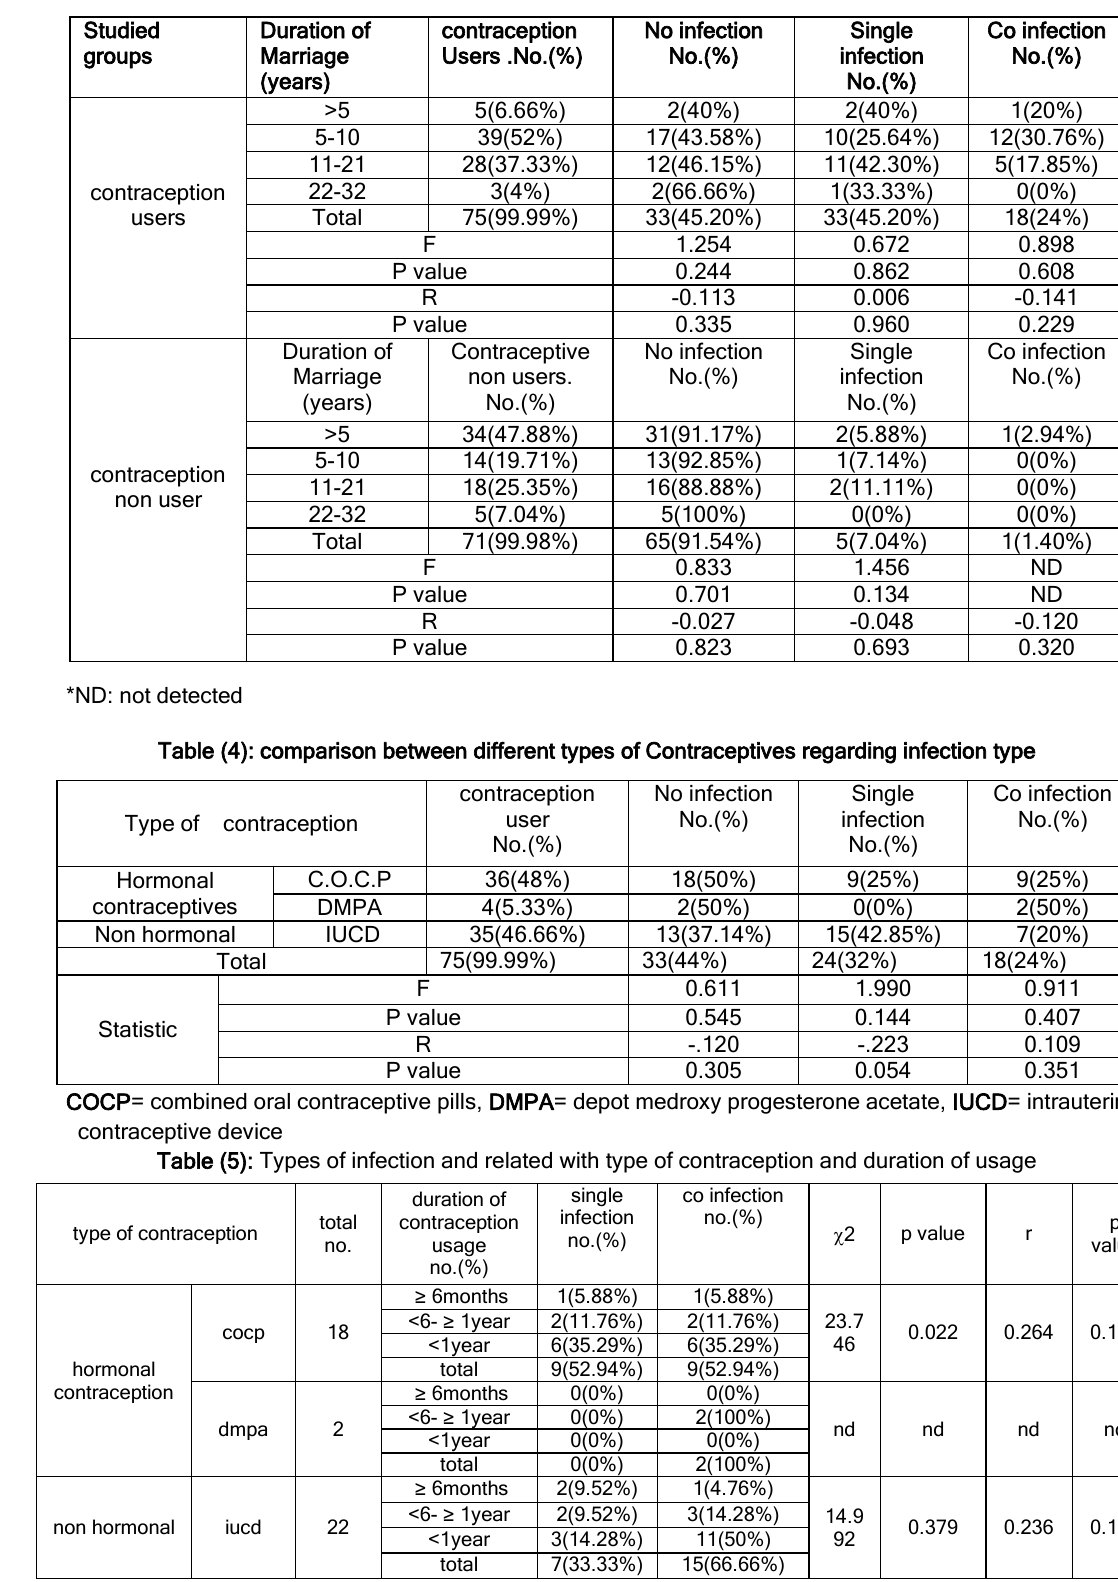
Table (3): Comparison between studied groups regarding infection and duration of Marriage